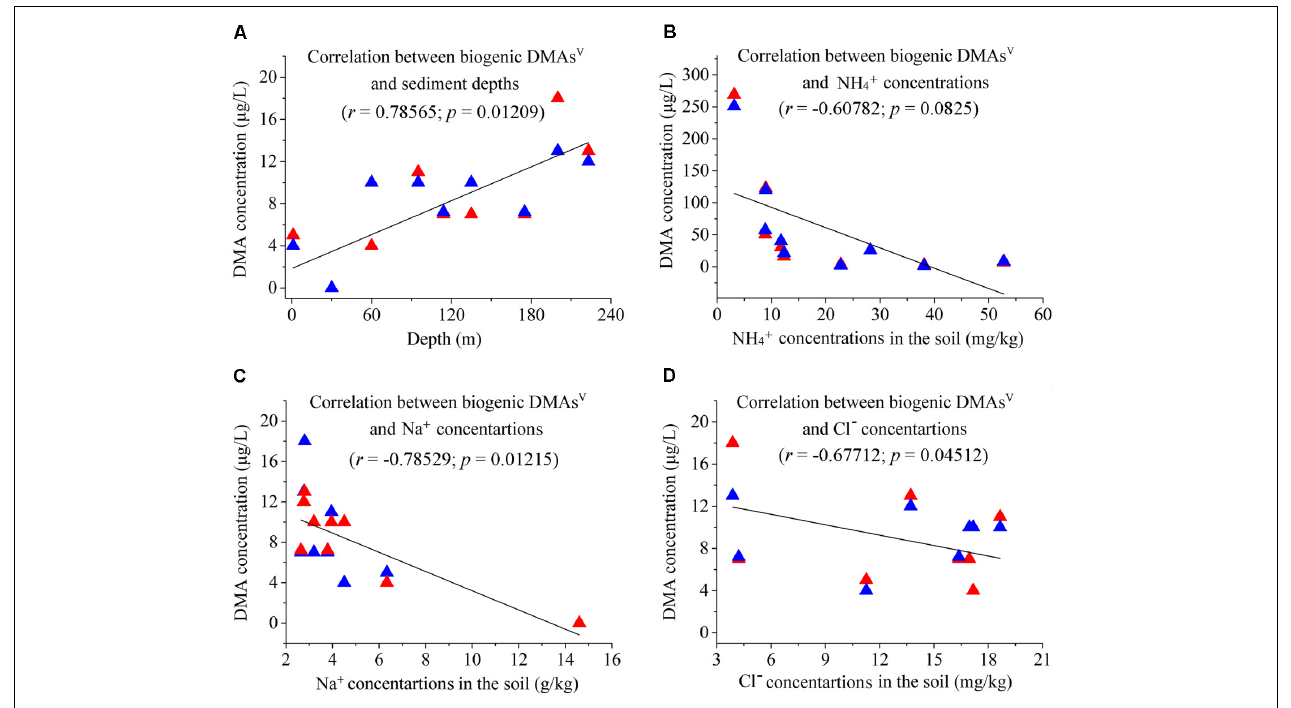
FIGURE 4 | Correlations between arsenic biomethylation and some environmental parameters. The red and blue triangles represent two different assays. (A) Correlation between biogenic DMAs V and sediment depths ( r = 0.78565, p = 0.01209); (B) Correlation between biogenic DMAs V and concentrations of environmental NH 4 + ( r = –0.60782, p = 0.0825); (C) Correlation between biogenic DMAs V and concentrations of environmental Na + ( r = –0.78529, p = 0.01215); (D) Correlation between biogenic DMAs V and concentrations of environmental Cl - ( r = –0.67712, p =